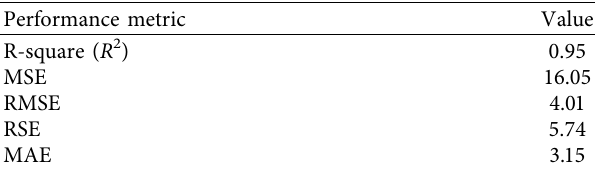
Table 8: Performance metrics of the